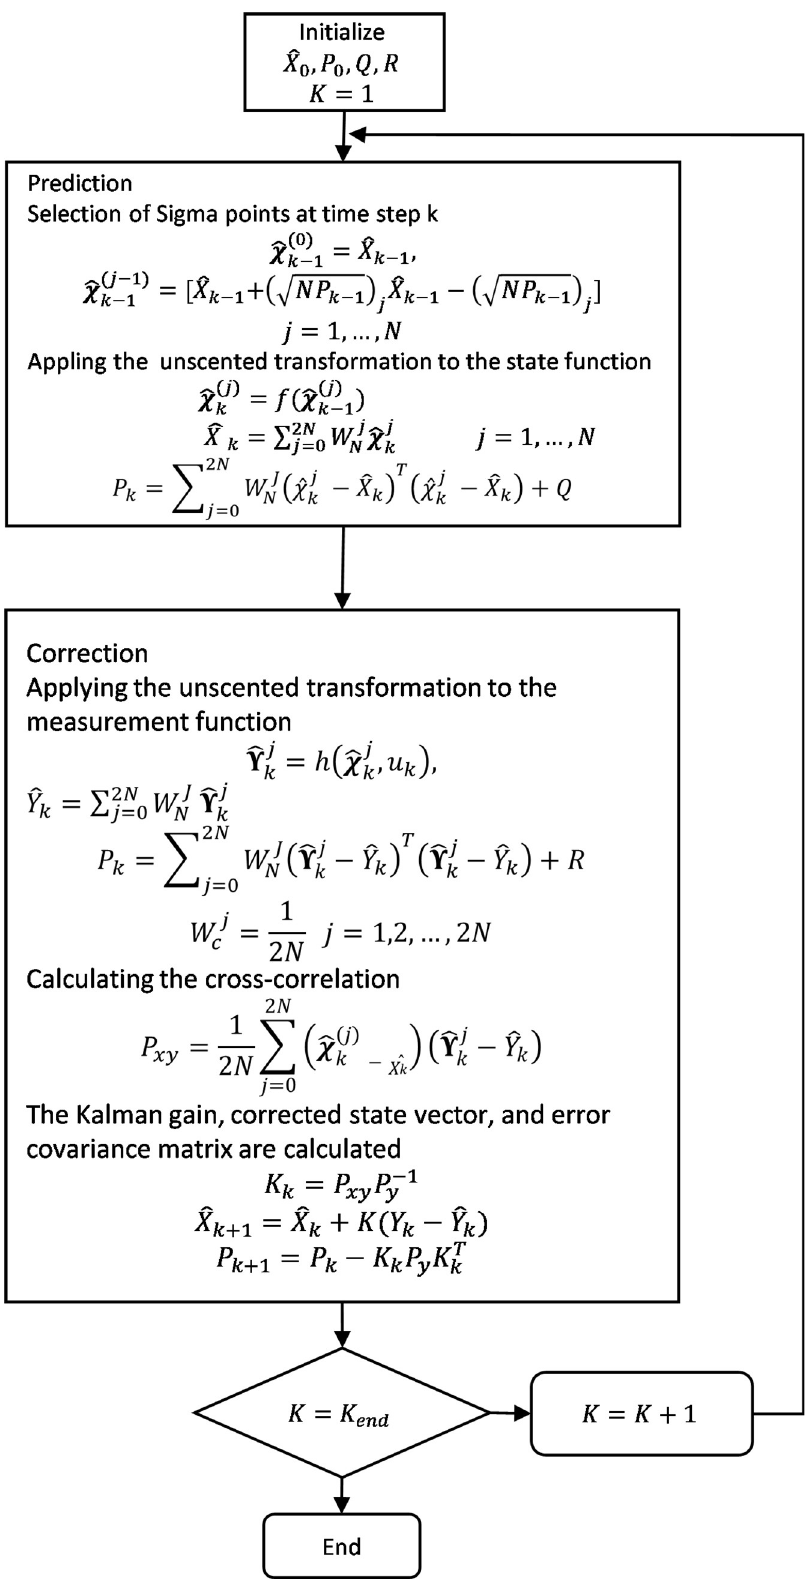
Fig 3. Block diagram of the simulation environment involving the estimation of the proposed estimator. https://doi.org/10.1371/journal.pone.0257849.g003 PLOS ONE | https://doi.org/10.1371/journal.pone.0257849 November5,